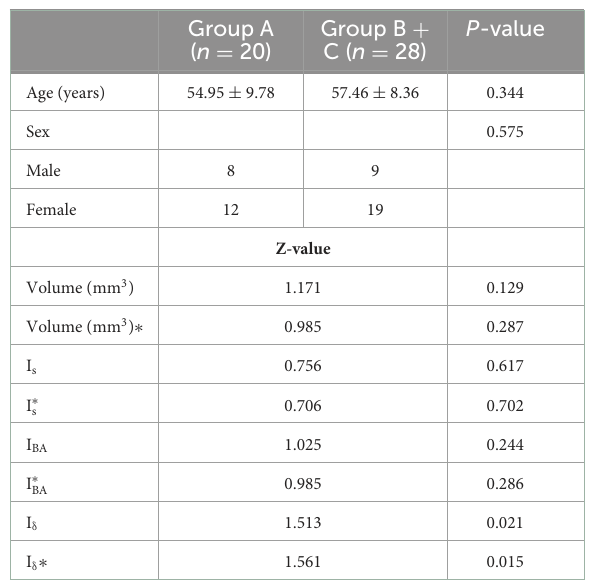
TABLE 2 Statistical results of parameters related to ruptured and unruptured aneurysms.